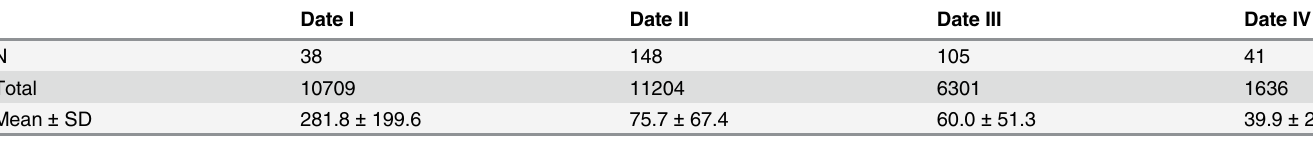
Table 1. Temporal changes in the population size, total number of culms, and mean number of culms per